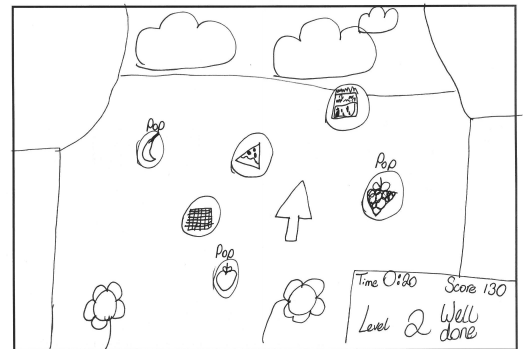
Figure 4. Example of a food pop game The results of the coding of the drawings based on Hofstede’s dimensions are presented in table 4 below. Table 4. The number of children’s drawings matching the Hofstede’s